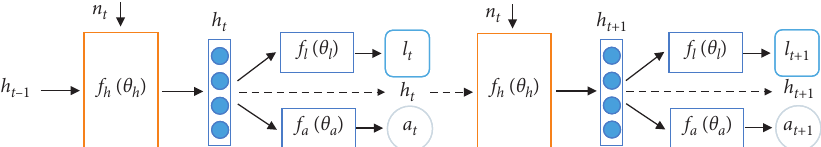
Figure 5: The input parameters of inner LSTM. Each hidden unit h its update is h t � f h ( h t −